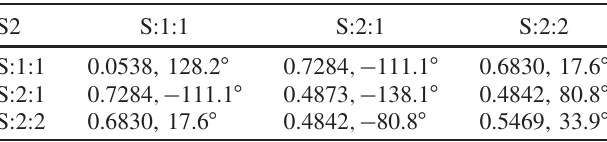
TABLE II. The scattering matrix of device in Fig. 6.